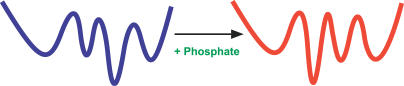
Phosphorylation Can Perturb the Energy Landscape of a Protein to Cause Changes in Conformation and DynamicsThis figure is a visual representation of such changes. In this work, we predict the structural change of proteins due to phosphorylation by locating the new global energy minimum of the energy surface.